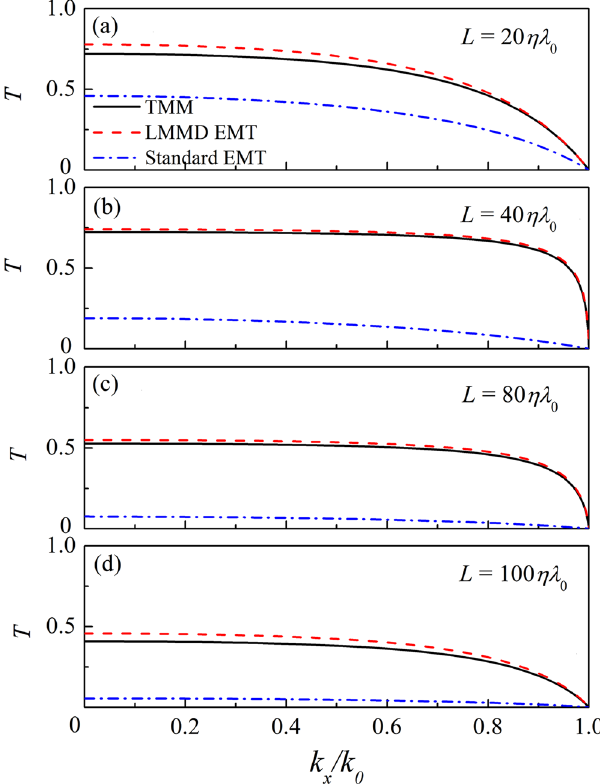
Figure 2. Transmissivity of the LMMD medium slab with thicknesses of ( a )